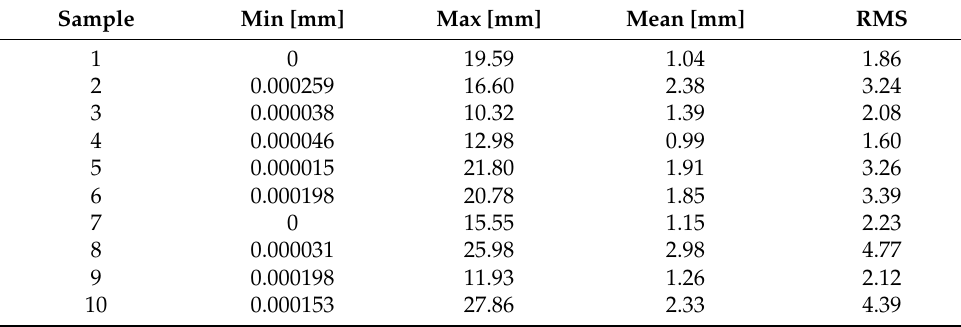
Table 5. Forward movement Hausdorff